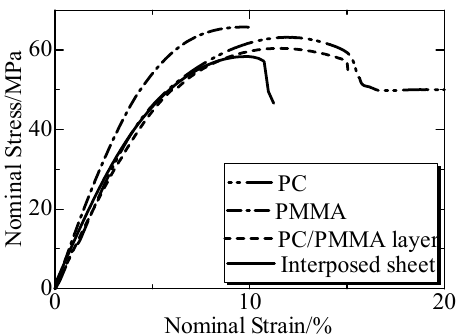
Figure 9. Nominal stress-strain curves of PC, PMMA, PC/PMMA composite and IPS. Adapted from Reference [149].